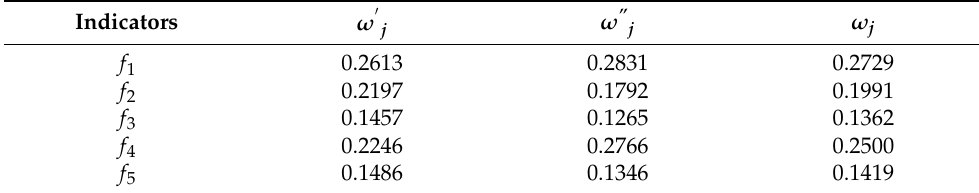
Table 10. The combined weight of each